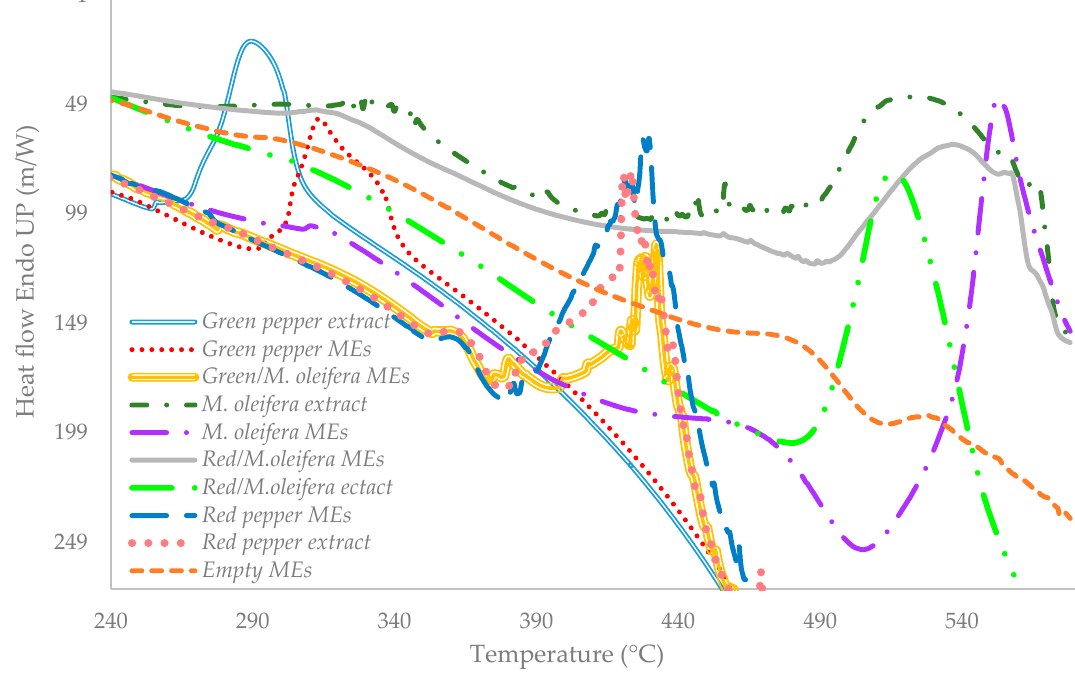
Figure 4. Differential Scanning Calorimetry (DSC) diagrams.